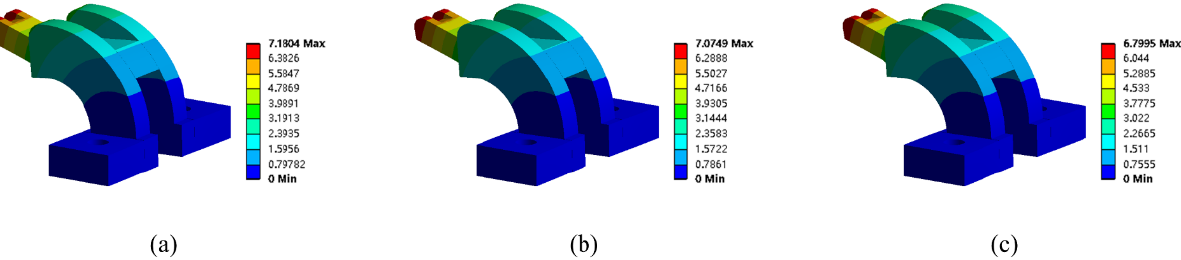
Figure 12. The deformation nephograms of the structures with different cross-infills: ( a ) 90° – 90°, ( b ) 90° – 0°, and ( c ) optimized cross-infill angles.